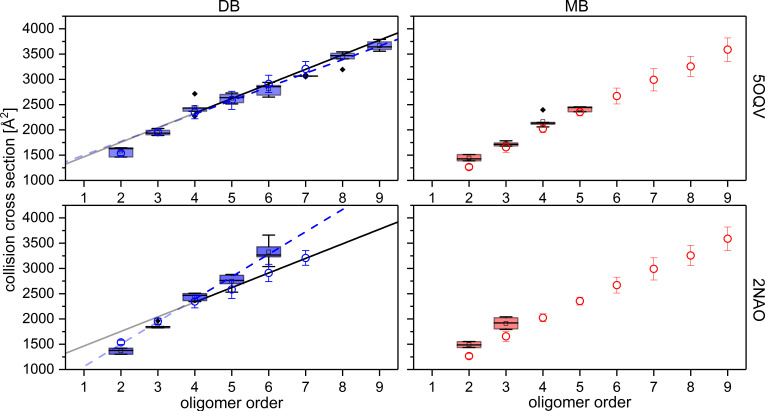
Comparison of experimental CCS values (blue circles for DB conformation on the left and red circles for MB conformation on the right) to CCS values of MD simulated PDB structures (box plots, using a minimum of five calculated structures) of Aβ42 oligomers.For comparison the structures detected with cryo-EM by Gremer, et al. (PDB 5OQV) and with solid-state NMR by Wälti, et al. (PDB 2NAO) were used for MD simulations and CCS calculations as illustrated above (Gremer et al., 2017; Wälti et al., 2016). Linear fits for oligomers from tetramer on, demonstrate the difference between experimental (solid) and theoretical (dashed) CCS of the DB conformation. The structure of PDB 5OQV (upper plots) matches our experimentally determined CCS values best.